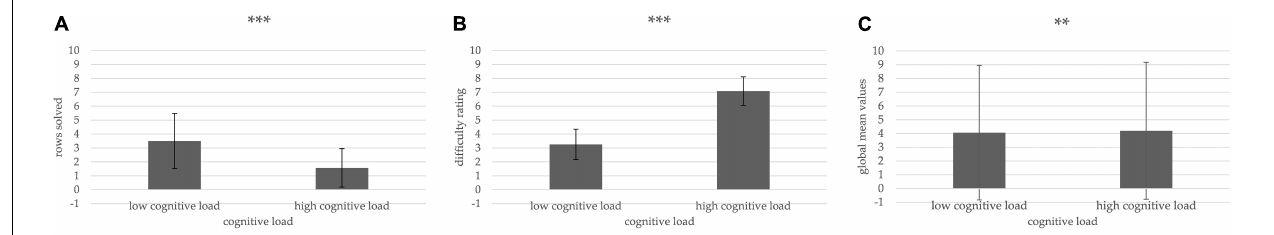
FIGURE 4 | Influence of cognitive load on number of rows solved, difficulty ratings and Global Mean values. The number of rows solved decreased during the high compared to low cognitive load condition (A) . Difficulty ratings increased under the high compared to low cognitive load condition (B) . The Global Mean values of skin conductance response (SCR) increase with high compared to low cognitive load (C) (** p < 0.01, *** p < 0.001, error bars portray one standard deviation).